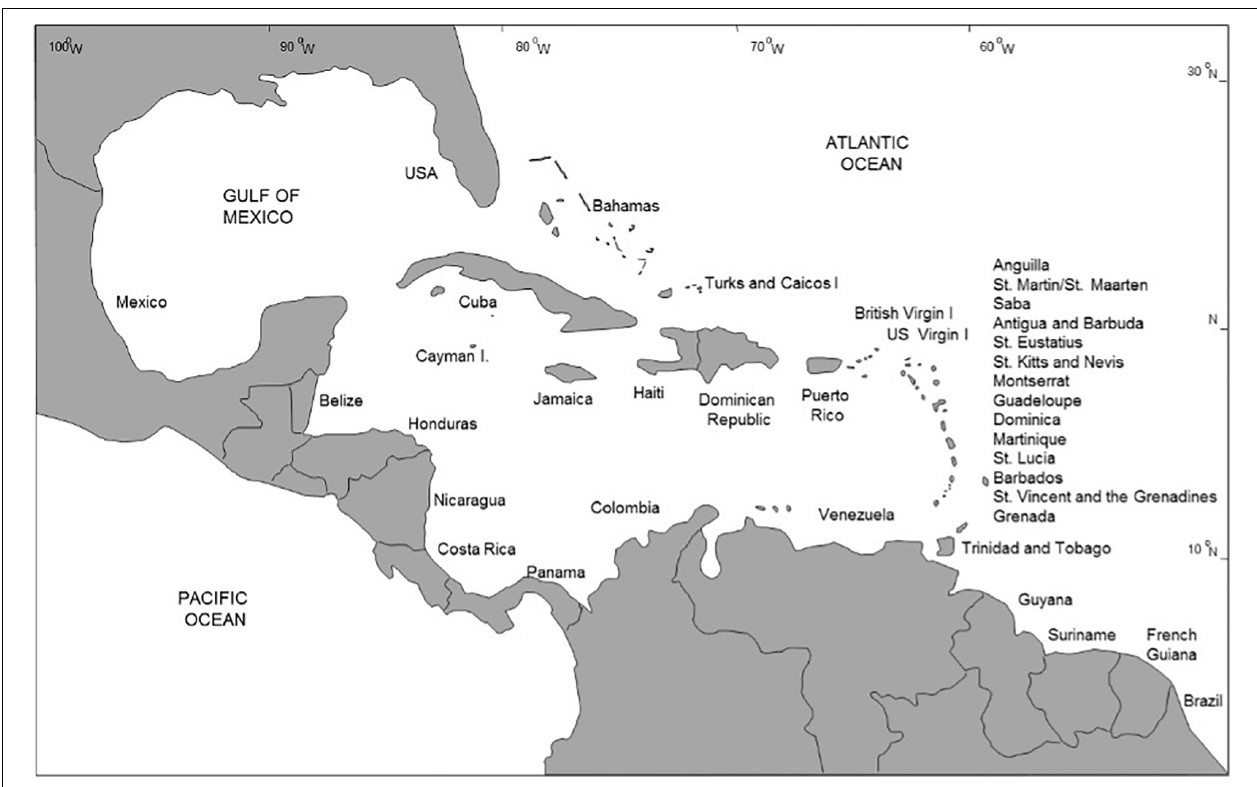
FIGURE 1 | Map of countries in the Wider Caribbean